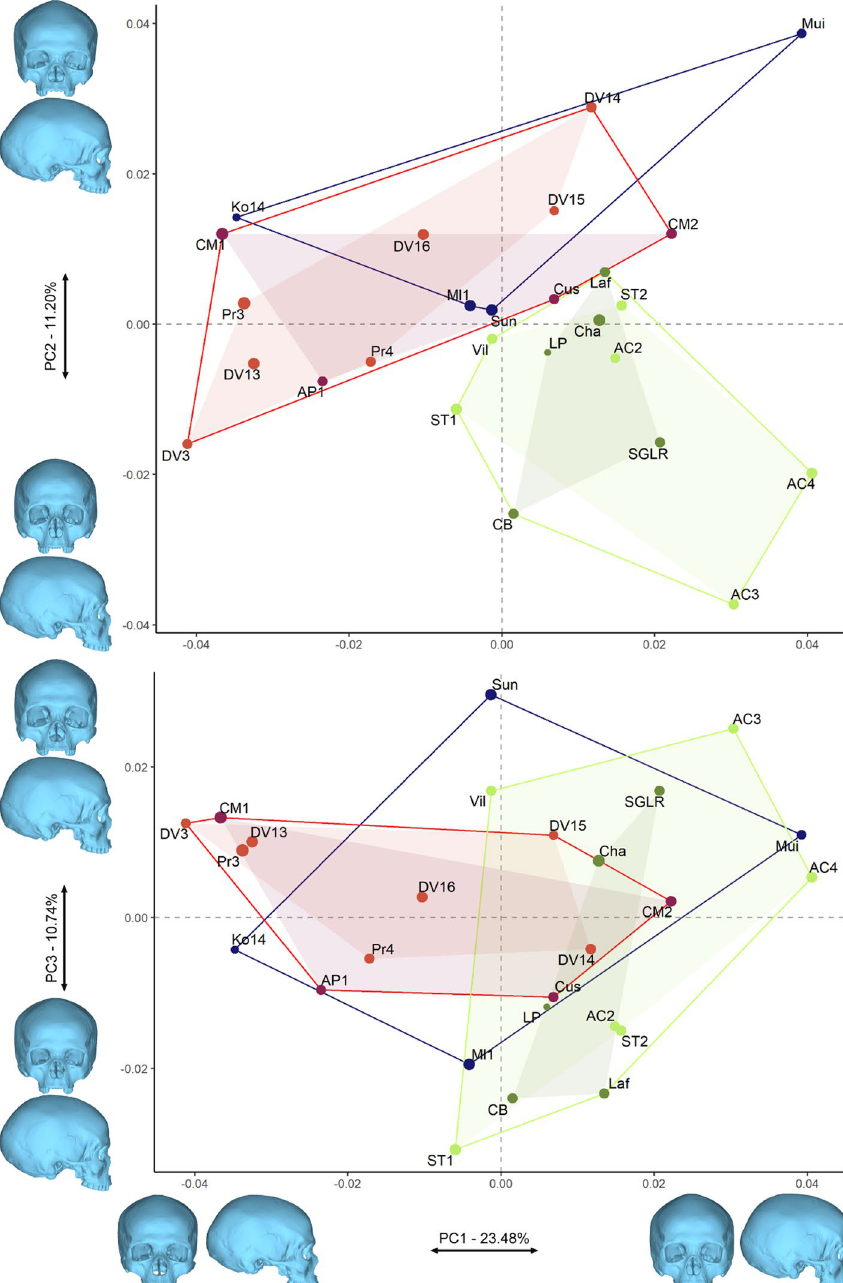
Figure 2. PC1, 2 and 3 representing 45.43% of the variation of the morphospace. Convex hulls show the morphological variation of the specimens (dark blue: EUP; red: MUP, MUPswf in violet and MUPmor in red; green: LUP, dark green LUPswf and light green LUPita). The size of the data points reflects the centroid size of the specimens. PC1 and 2 separates the MUP and EUP samples from the LUP